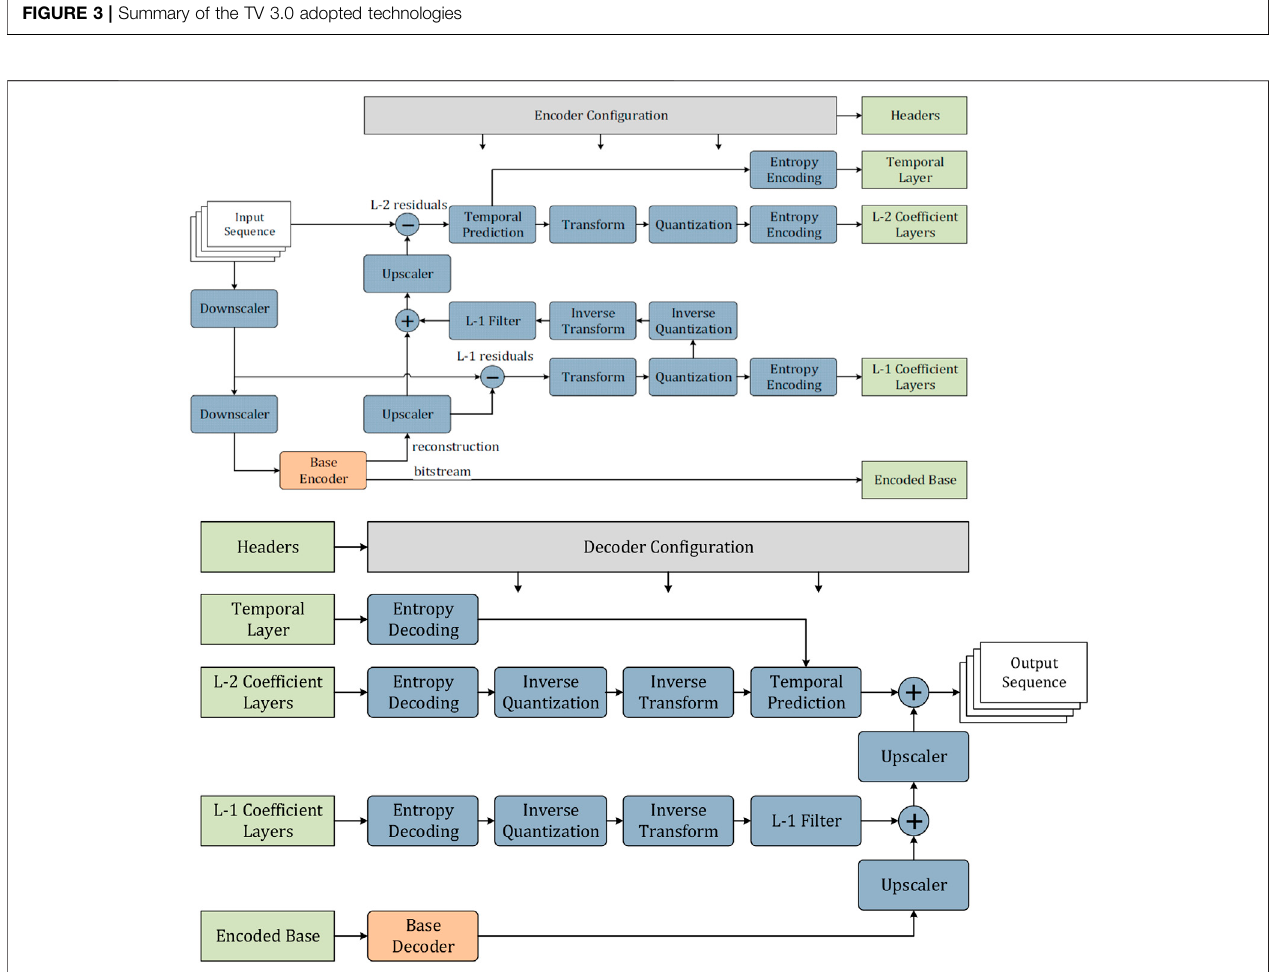
FIGURE 4 | Structure of an LCEVC encoder and decoder